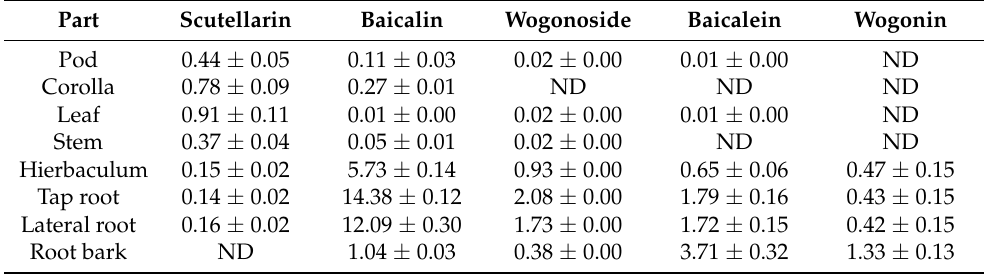
Table 3. Contents of baicalin, baicalein, wogonoside and wogonin in different parts of Scutellaria baicalensis Georgi (%, n = 3).